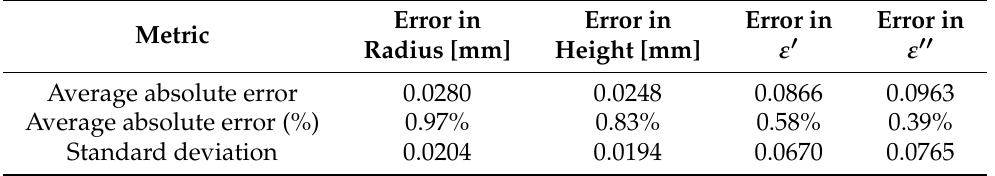
Table 2. Summary of error in predictions for the noise-free synthetic test